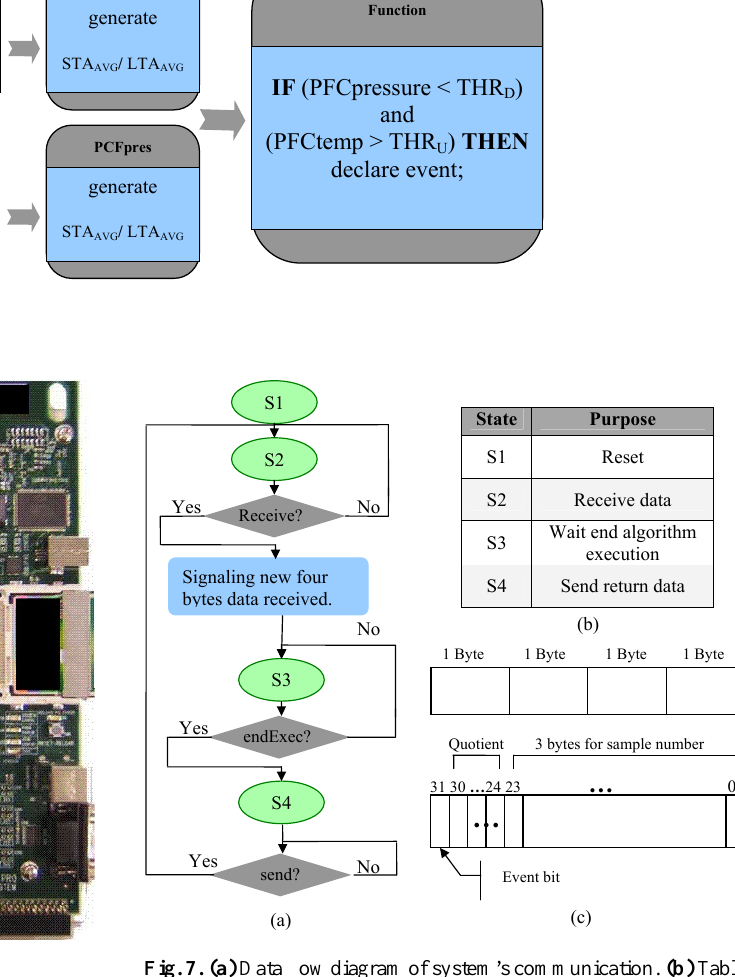
Fig. 6. XUPV2P30 Development System. Fig. 7. (a) Data flow diagram of system’s communication. (b) Table of states. (c) Frame sample and return value